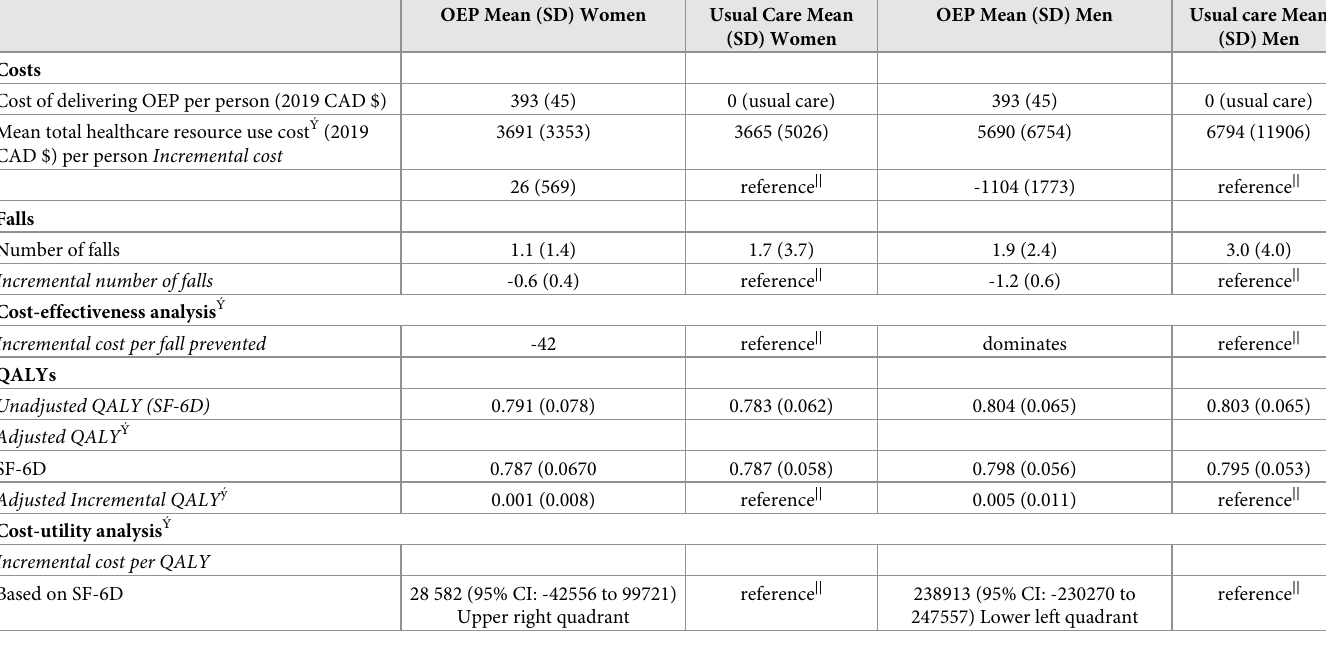
Table 2. Economic evaluation results of the cost-effectiveness and cost-utility study (complete case analyses) stratified by